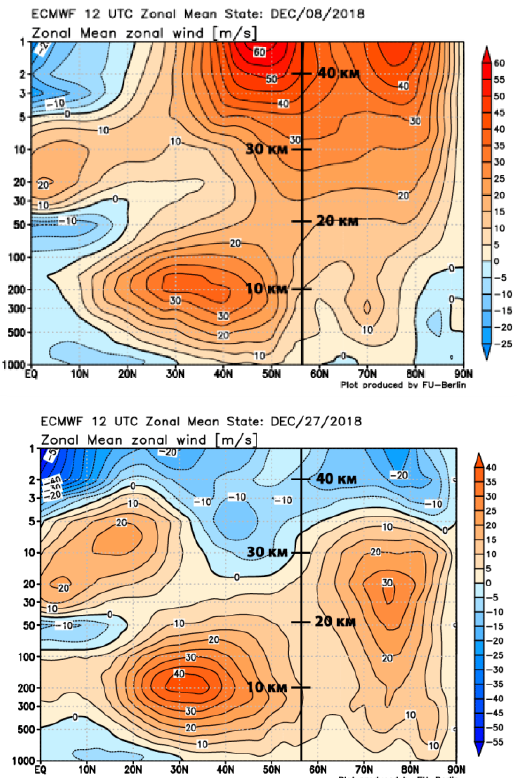
Fig. 9. Altitudinal distribution of zonal wind speed and direction in the Northern Hemisphere, recorded on December 8 and 27, 2018. Orange areas are for westerlies and blue areas for easterlies. The vertical thick lines indicate the altitudinal transects for the latitude of